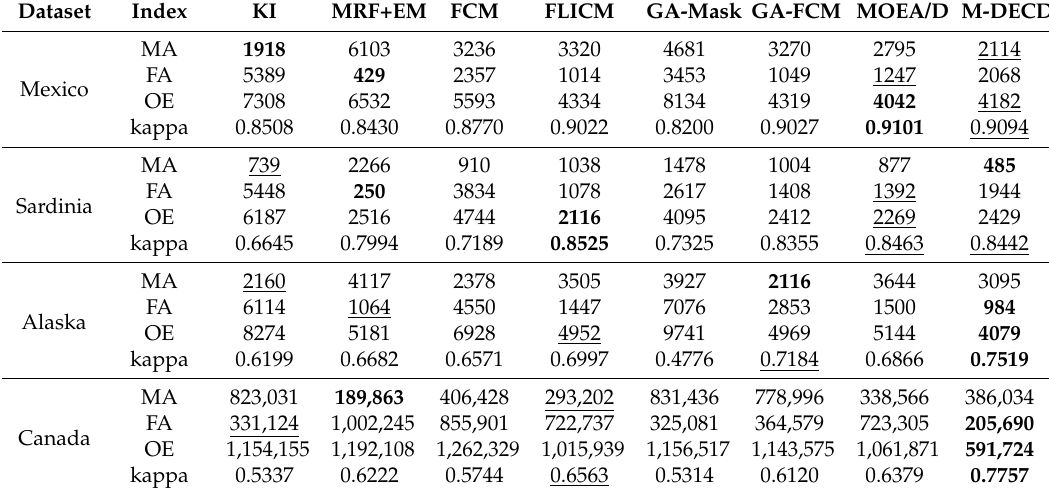
Table 4. Quantitative evaluation of the experimental results obtained with four datasets.